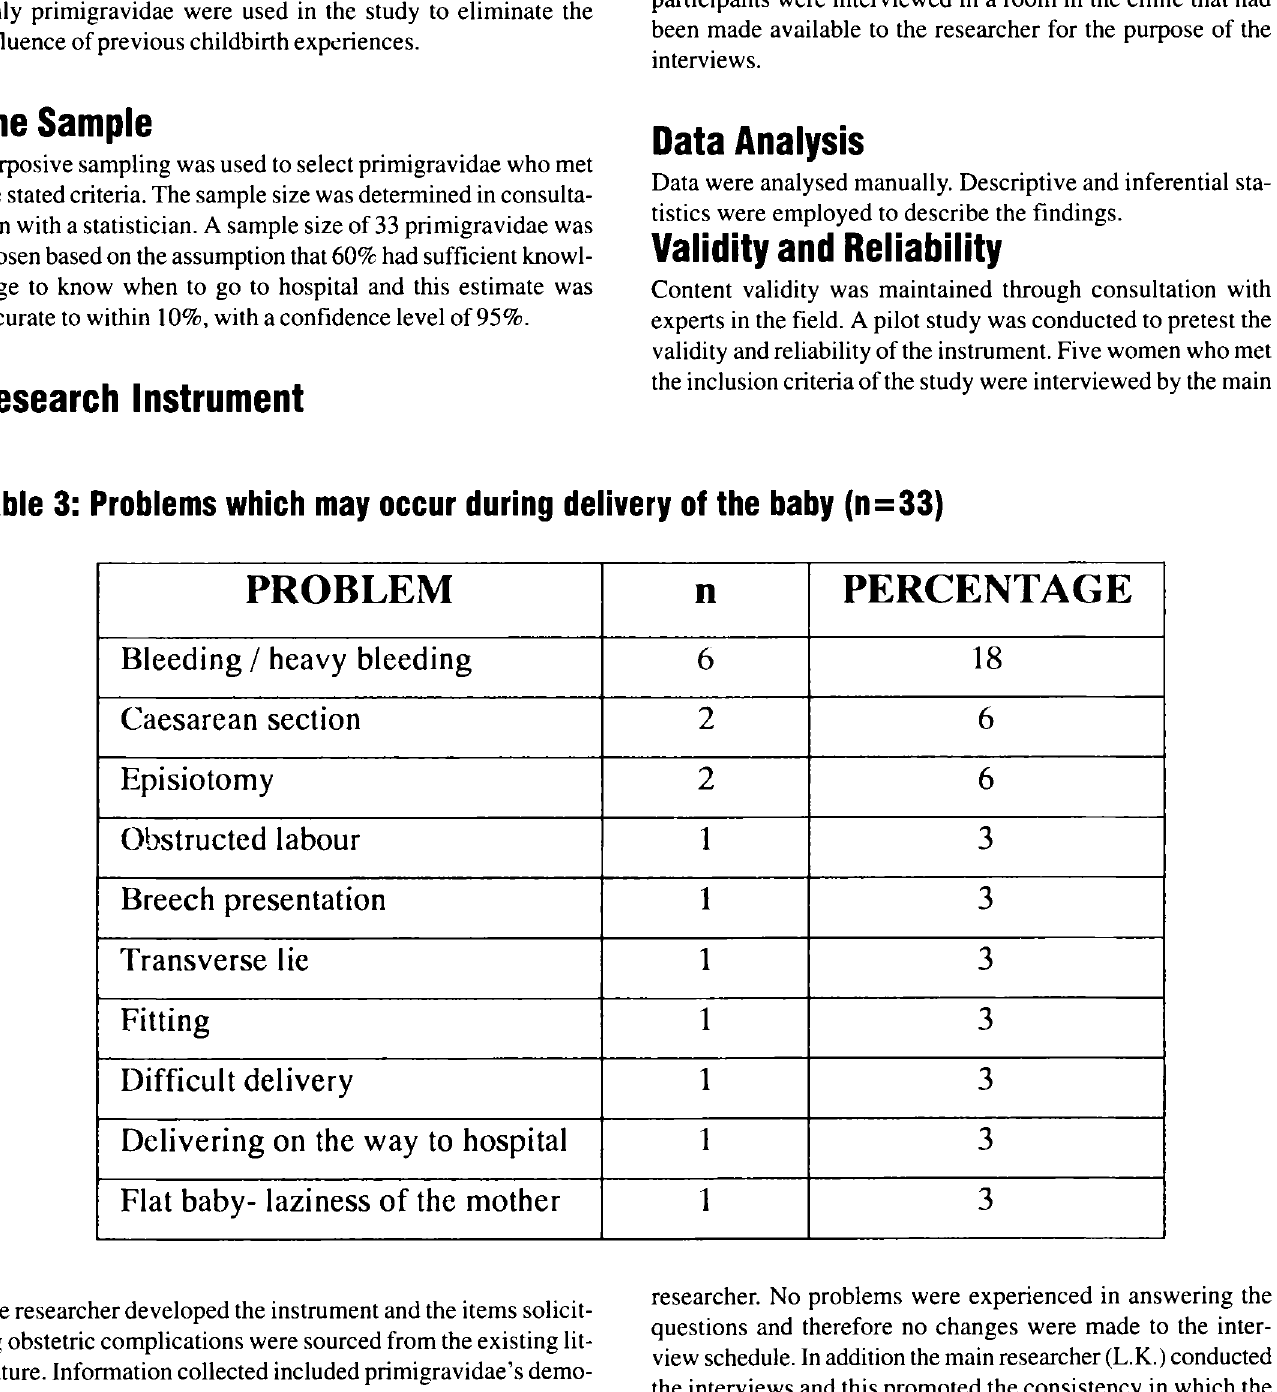
Table 3: Problems which may occur during delivery of the baby